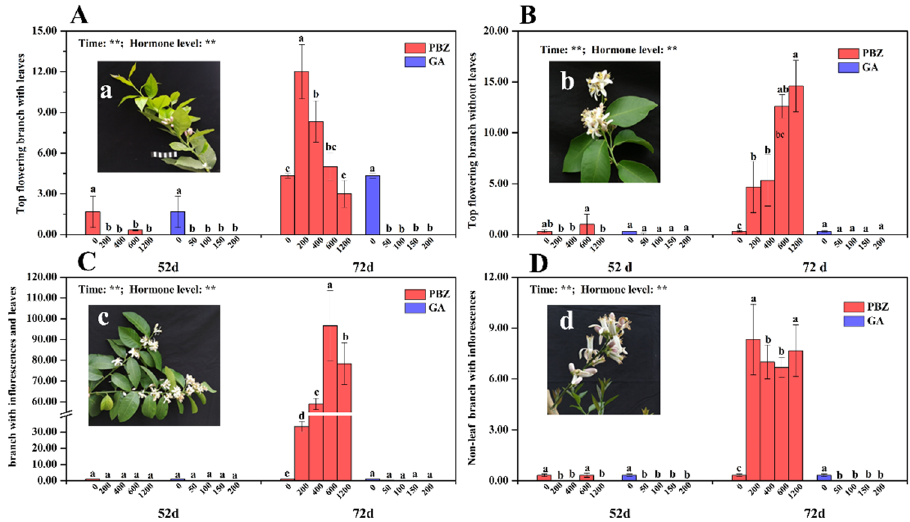
Figure 3. Effects of hormone regulation on the types and number of lemon flower branches: top flowering branch with leaves ( A ), top flowering branch without leaves ( B ), branch with inflorescences and leaves ( C ), and non-leaf branch with inflorescences ( D ).Different letters (a, b, c and d) denote significant differences based on a p value < 0.05. ** denotes extremely significant difference ( p < 0.01).